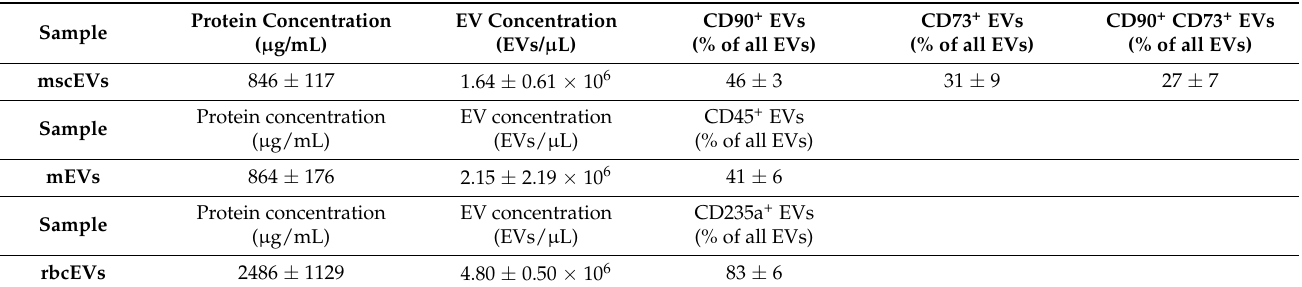
Table 1. Characterization of applied EV